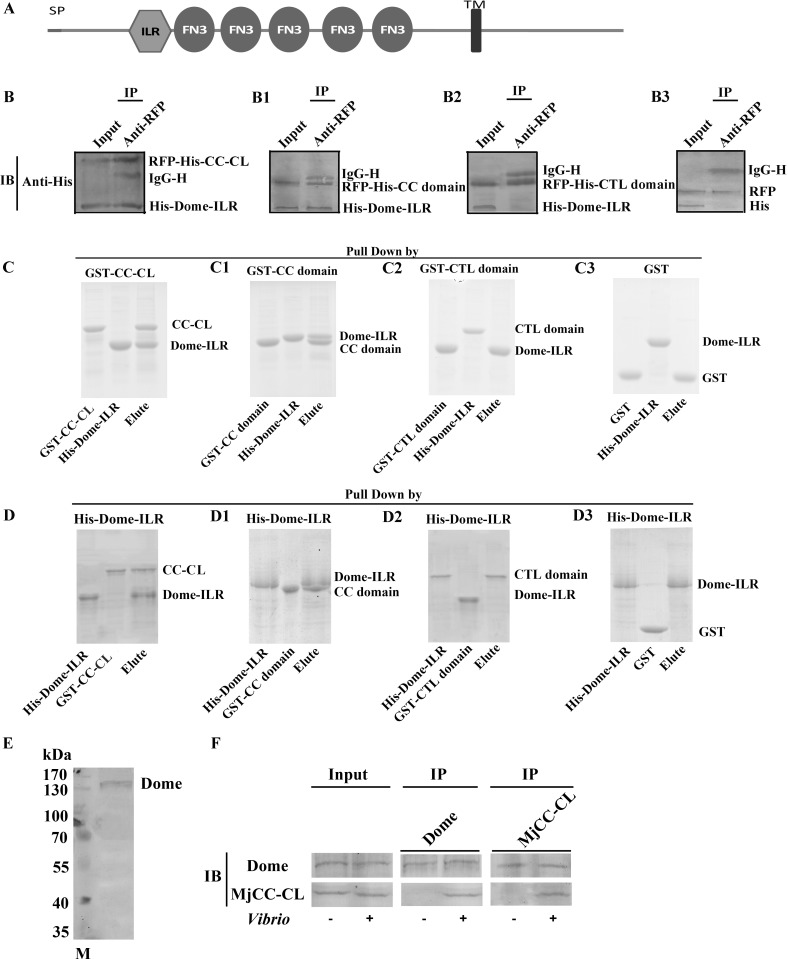
MjCC-CL interacts with the IL-R alpha domain of Dome.(A) The Dome receptor contains an SP, an IL-6R alpha domain (the receptor for interleukin 6), five FN3 domains (fibronectin type 3 domain) and a TM domain (transmembrane region). (B) MjCC-CL and the ILR domain of Dome were overexpressed in HaEpi cells, and co-IP was performed to detect the interaction between RFP-His-MjCC-CL and His-Dome-ILR using an anti-RFP antibody. The input lane showed that RFP-His-MjCC-CL and His-Dome-ILR were overexpressed in HaEpi cells before immunoprecipitation. Co-IP performed with the anti-RFP antibody showed the interaction between MjCC-CL and Dome-ILR. An anti-His antibody was used to detect the corresponding proteins. (B1) Co-IP was used to detect the interaction between the CCD of MjCC-CL and the ILR domain of Dome with an anti-RFP antibody. (B2) Co-IP was used to detect the interaction between the CTL domain of MjCC-CL and the ILR domain of Dome using an anti-RFP antibody. (B3) Control co-IP to detect the interaction of RFP with the His tag using anti-RFP antibody. (C) A GST pulldown assay was performed to detect the interaction between MjCC-CL and the ILR domain of Dome. (C1-C2) The interactions between the CCD of MjCC-CL (C1) or the CTL domain of MjCC-CL (C2) and the ILR domain of Dome were analyzed with a pulldown assay. (C3) GST pulldown was used as a control. (D) A His pulldown assay was performed to detect the interaction between the ILR domain of Dome and MjCC-CL. (D1-D2) The interactions between the ILR domain of Dome and the CCD of MjCC-CL (D1) or the CTL domain of MjCC-CL (D2) were analyzed using a pulldown assay. (D3) The interaction between the ILR domain of Dome and GST was used as a control. (E) Western blotting indicated the molecular masses of native Dome by detection with polyclonal antibody. The molecular weight markers were from Thermo Fisher Scientific, Lithuania. (F) Co-IP was performed using anti-Dome and anti-MjCC-CL antibodies in intestine after Vibrio challenge; MjCC-CL and Dome were detected by their corresponding antibodies. The experiments were repeated three times.